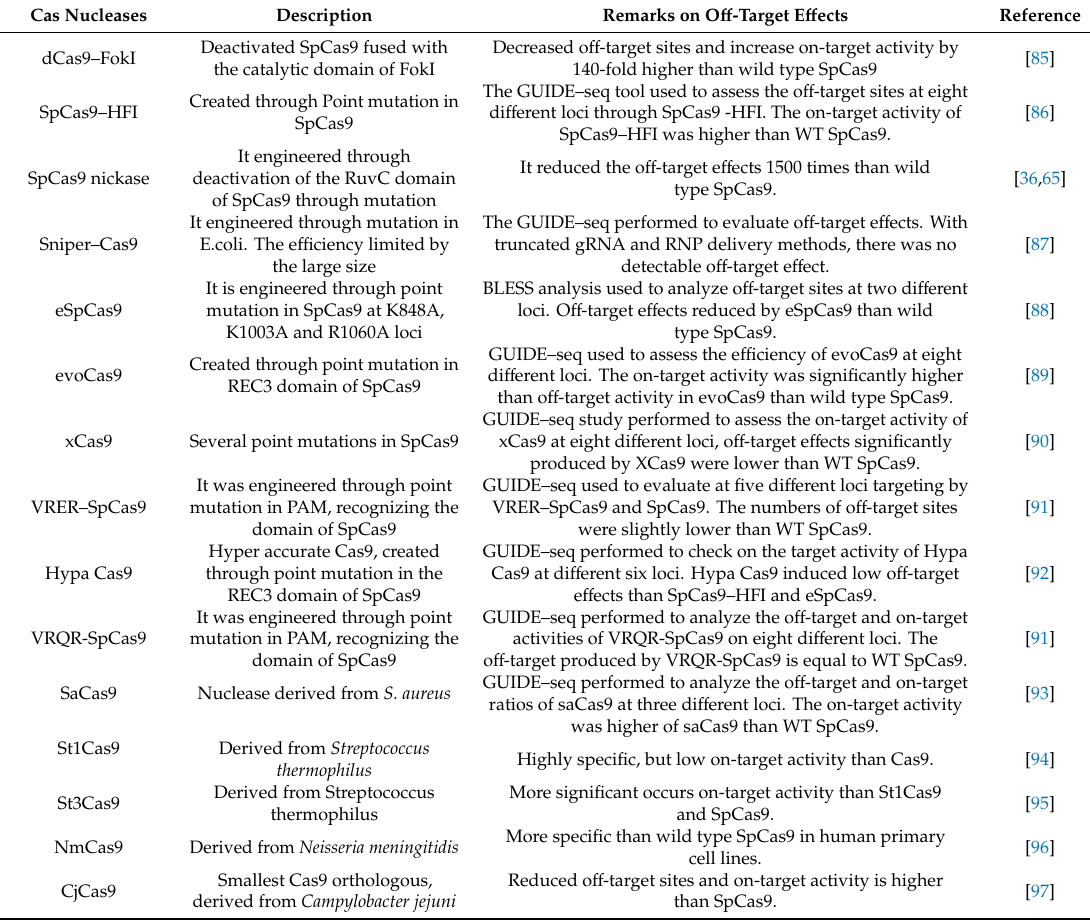
Table 4. Characteristics of Cas9 variants and their